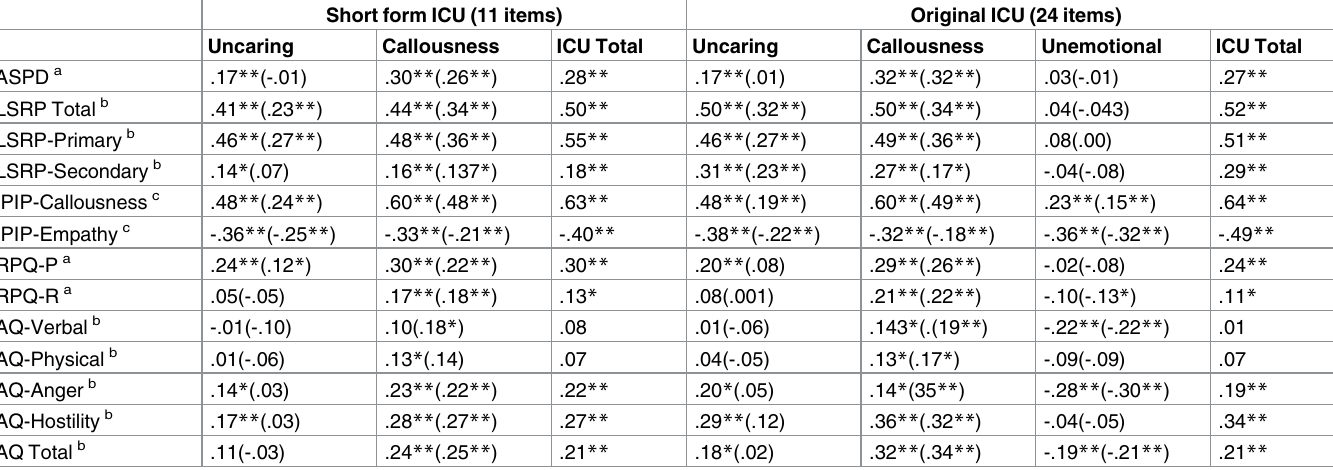
Table 5. Correlational and regression analysesbetween ICU and external criteria measures. Short form ICU (11